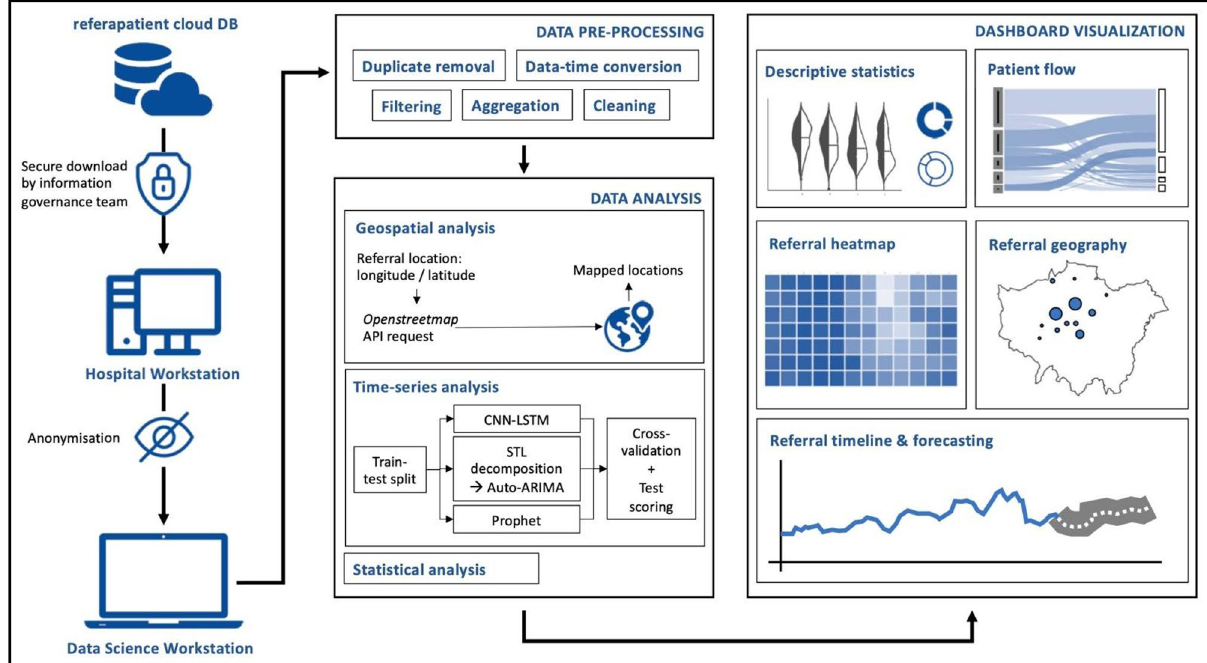
Figure 1. Data acquisition, processing, analysis and visualization pipeline ( CNN-LSTM convolutional neural network—long short-term memory, STL seasonal and trend decomposition using Loess, ARIMA automated regression integrated moving